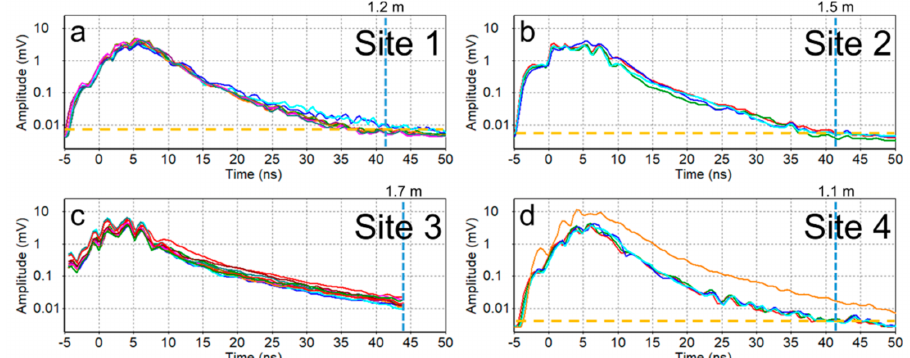
Figure 12. Average trace amplitude plots marked (in blue dashed lines) with approximate GPR signal penetration depths (PDs): ( a ) Site-1, ( b ) Site-2, ( c ) Site-3 (from the recent survey conducted on 10 December 2019), and ( d ) Site-4. Yellow dashed lines mark the approximate threshold voltage representing the radio frequency noise floor. Note that the PDs expressed in the distance (m) are marked on the top of each